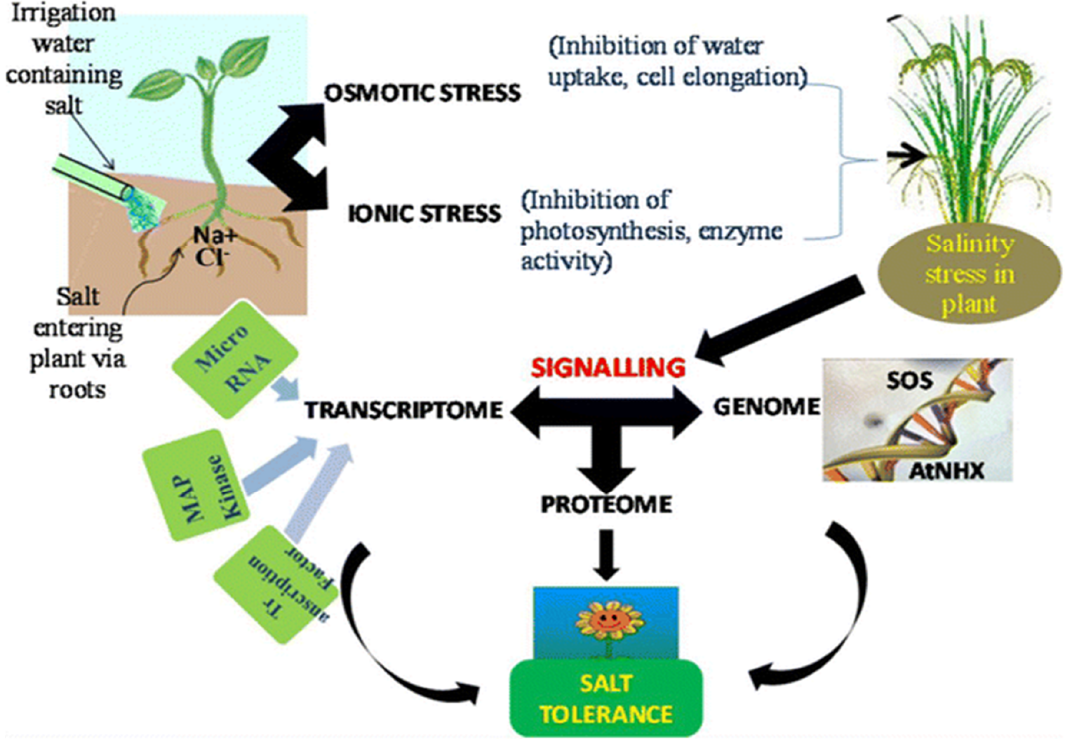
Figure 4. Schematic diagram showing routes of salt stress toxicity and various tolerance strategies in plants. Putative roles and action of genes, transcription factors, mitogen-activated protein kinases, microRNAs, and metabolites are shown [236].